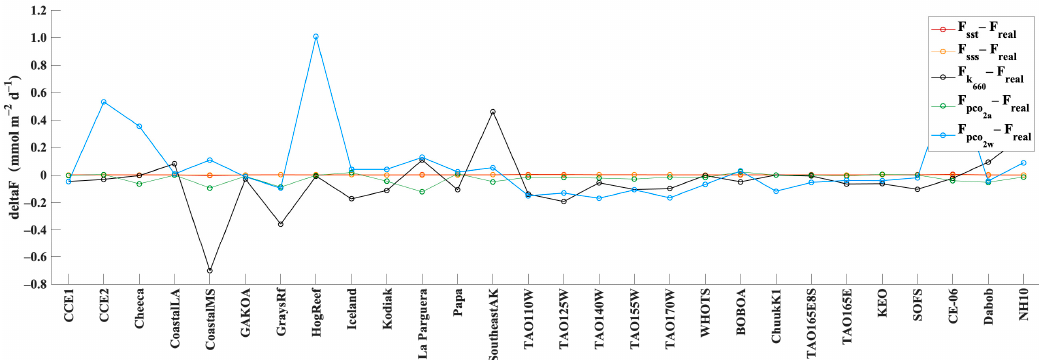
Figure 6. Effects of single factors on the calculated CO 2 flux at global stations from 2010 to 2020. The vertical coordinate is the difference between Freal and the CO 2 flux calculated after controlling for a single influencing factor.